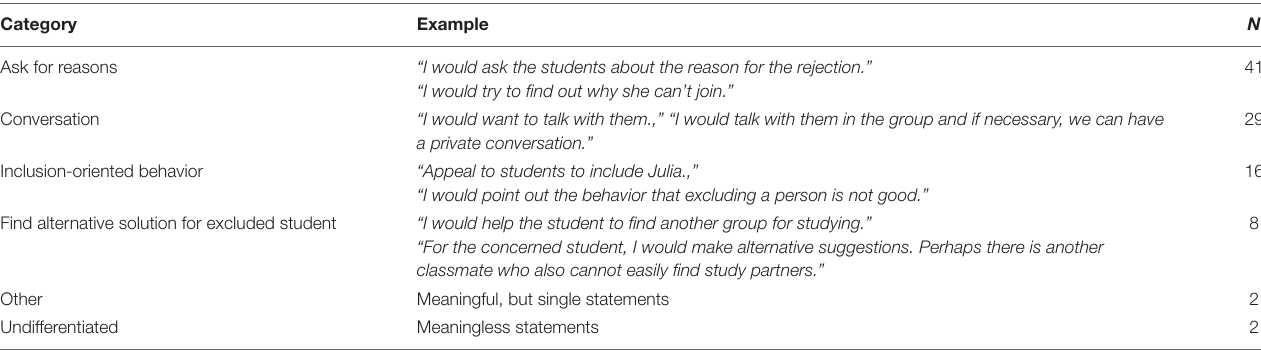
TABLE 2 | Coding system for specific actions and frequencies for each